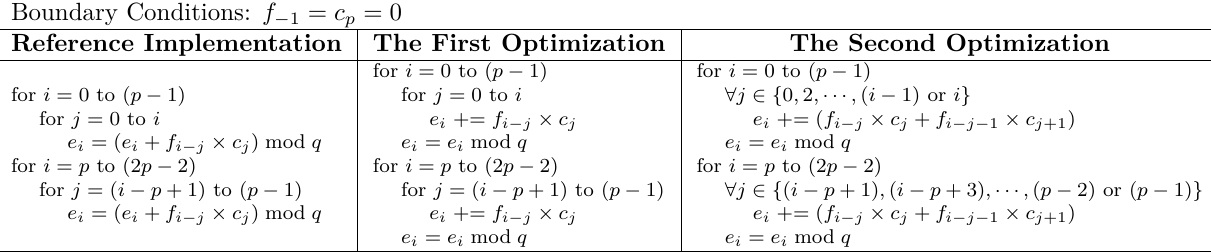
Table 3: The Two Optimizations at the Instruction